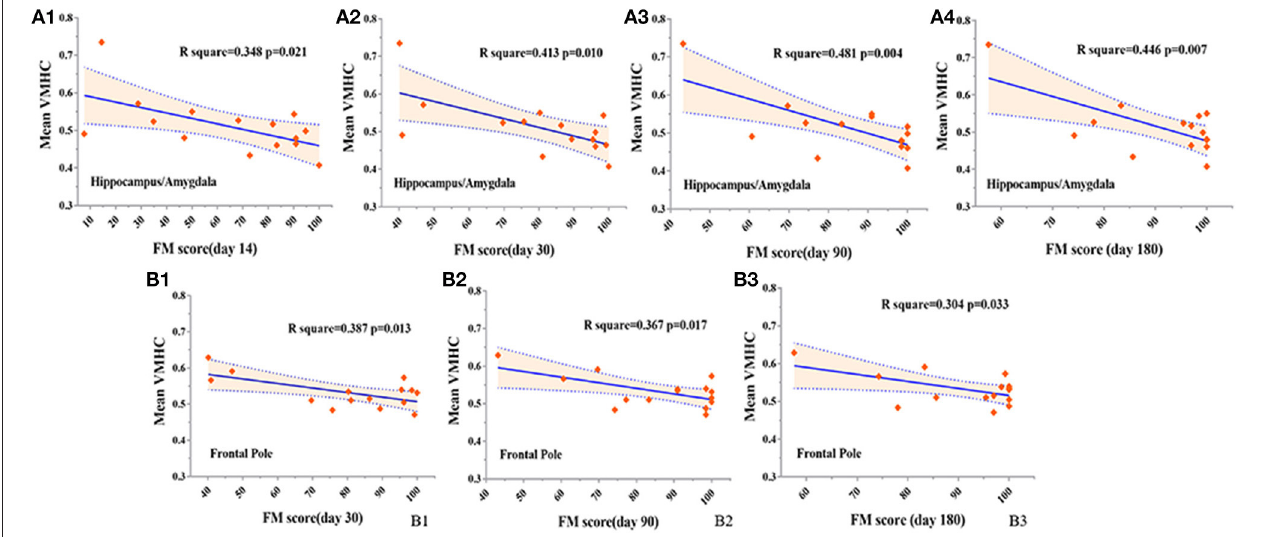
FIGURE 5 | Correlations between VMHC changes (within 7 days after stroke onset) and FM (4 visits during 6 months) in patients with stroke. In the hippocampus/amygdala, negative correlations are shown between VMHC and FM on day 14 (A1) , day 30 (A2) , day 90 (A3), and day 180 (A4) after stroke onset, at a threshold of P < 0.05. In the frontal pole, negative correlations are presented between VMHC and FM on day 30 (B1) , day 90 (B2) , and day 180 (B3) after stroke, at a threshold of P < 0.05. VMHC, voxel-mirrored homotopic connectivity. FM, Fugl–Meyer